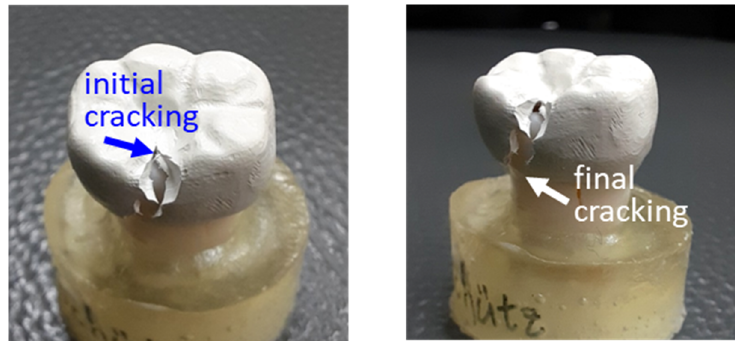
Figure 6. Visually macroscopic observation of the fracture morphology of PEEK crown after com- pression test: initial cracking ( left ) and final cracking ( right ).